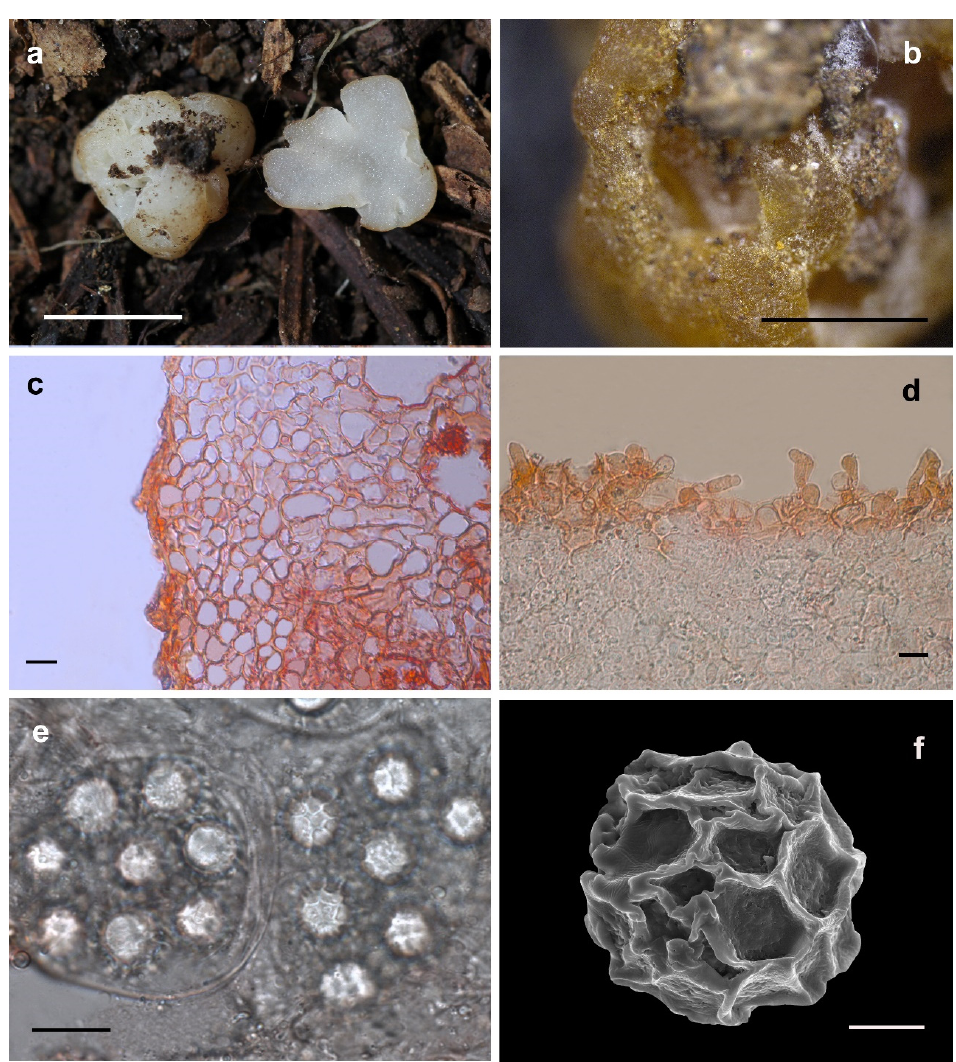
Figure 6. Hydnobolites sichuanensis (Holotype, YNAU0705). ( a ) Fresh ascoma and gleba; ( b ) dried ascoma; ( c ) peridium; ( d ) paraphyses; ( e ) asci and ascospores under LM; ( f ) ascospore under SEM. Scale bars: a = 1 cm; b = 1 mm; c–e = 20 µm; f = 5 µm. 3.2.5. Hydnobolites tenuiperidius S.P. Wan and F.Q. Yu, sp. nov. MycoBank: 846355 Etymology: In terms of the thin-peridiumed Peridium (Figure 7). Holotype: China, Yunnan Province, 25°07 ′ 18 ″ N and 102°50 ′ 24 ″ E, in humic soil under a pure Pinus armandii forest, at about 2222 m, 14 November 2021, wsp1751 (YNAU0899, GenBank accession: ITS = OM758150, LSU = OP642358). Diagnosis: Differs from other species by possessing extremely thin peridium (5.5– 222.8 µm). Description: Ascomata irregularly globose to subglobose, grooved, cracked, lobed and infolded, soft but firm, surface smooth, glabrous to tomentose, minutely downy in grooves and depression, 2.1–2.8 cm in diam., white when fresh, light red after a while, golden yellow to golden brown when dried. Odour none. Peridium 5.5–222.8 µm thick,